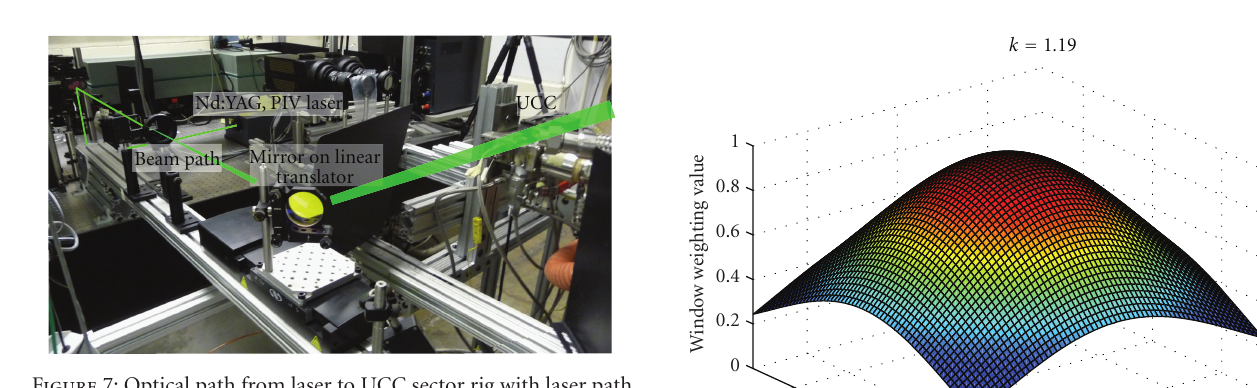
Figure 7: Optical path from laser to UCC sector rig with laser path drawn in green.